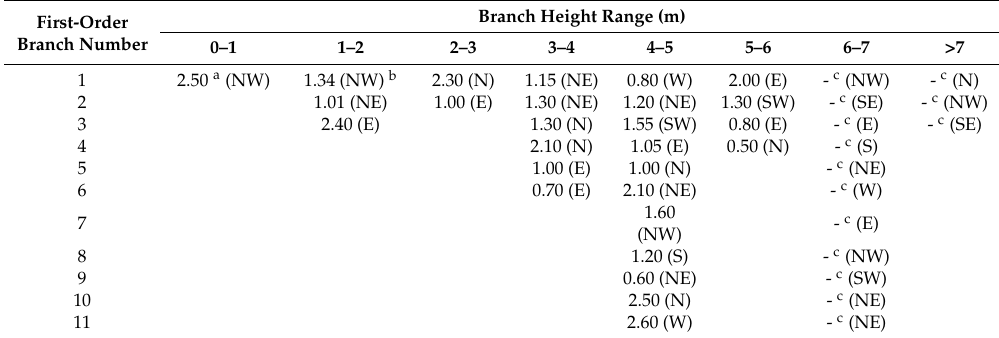
Table 1. Basal diameters and growth directions of first-order branches belonging to different branch height